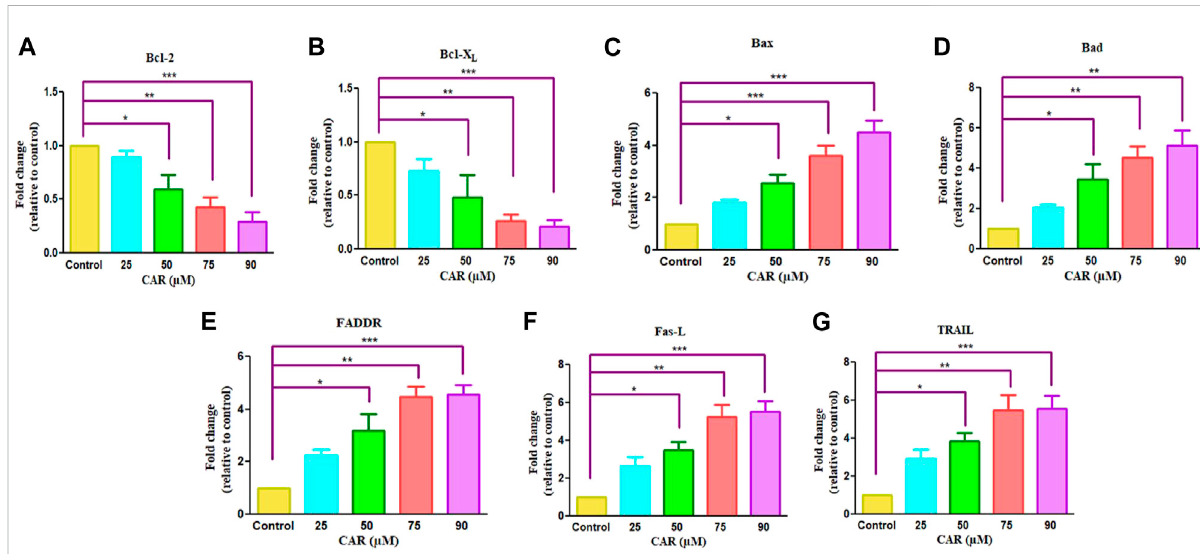
FIGURE 5 Effect of CAR on the mRNA expression of intrinsic and extrinsic apoptotic signaling molecules in C33A cells. Fold change in the mRNA expression of antiapoptotic proteins and proapoptotic proteins such as (A) Bcl-2, (B) Bcl-X L (C) Bax (D) Bad (E) FADDR (F) Fas-L and (G) TRAIL genes were analyzed by real-time PCR using SYBR Green dye. Target gene expression is normalized to GAPDH mRNA expression and the results are expressed as fold change from control. Data reported are mean ± SEM of three separate experiments each of which were performed in triplicates. Signi fi cant difference among the treatment groups were analyzed by two tailed Paired Student ’ s t-test and one-way ANOVA followed by Dunnett post hoc test (* p < 0.05 , ** p < 0.01 , *** p < 0.001 represent signi fi cant difference compared with control).